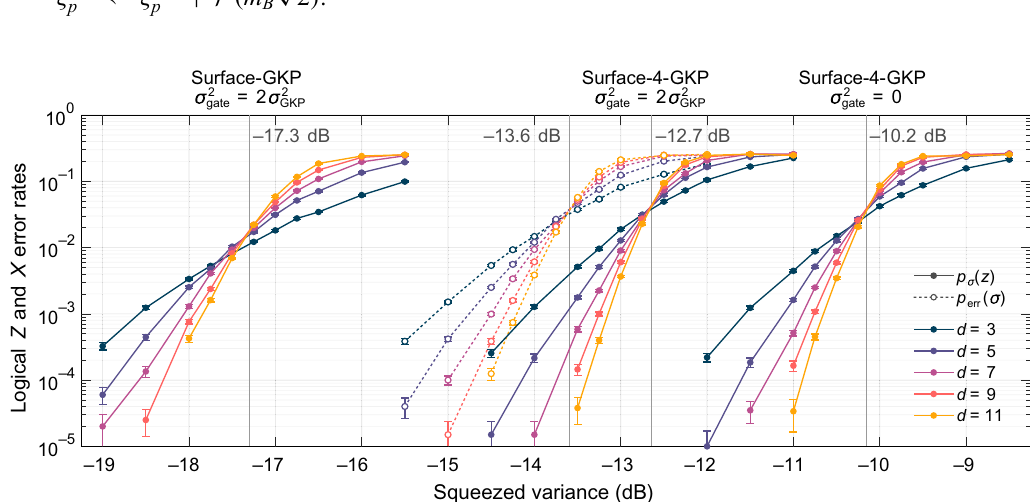
FIG. 6. Simulation results for all four simulated cases. Here, the case of the surface-4-GKP code using p σ ( z ) gives the results shown in the main text in Fig. 5. The error bars of standard deviation are estimated by